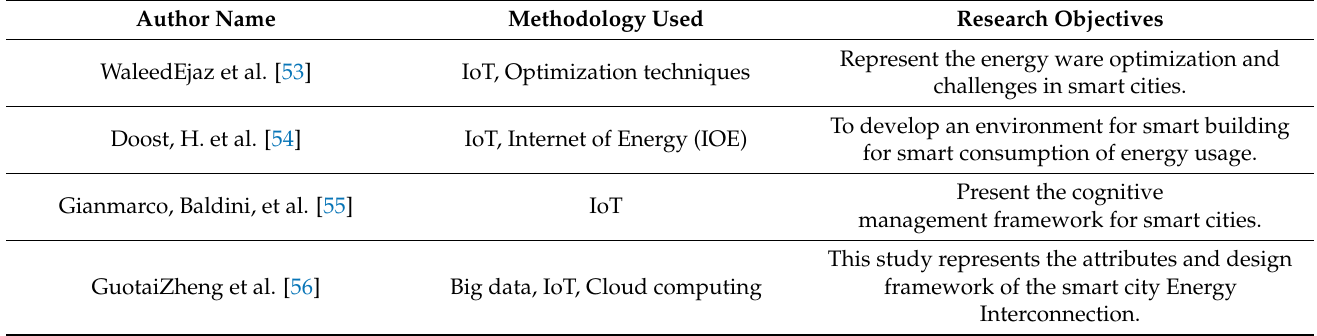
Table 4. Research articles based on smart cities and energy retention.